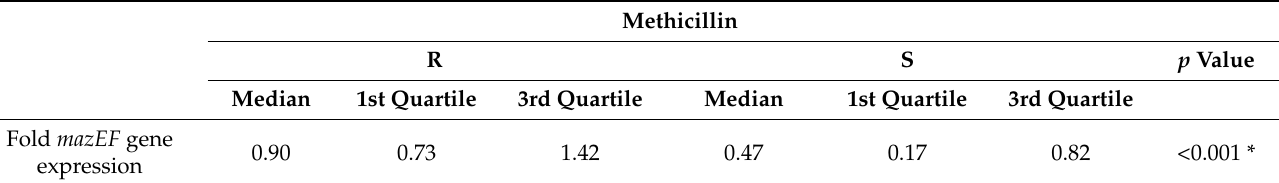
Table 2. The mazEF expression in relation to methicillin susceptibility.